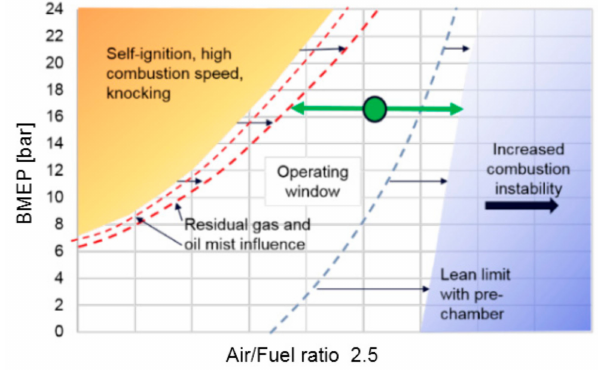
Figure 5. Lean-burn DF engine Otto combustion